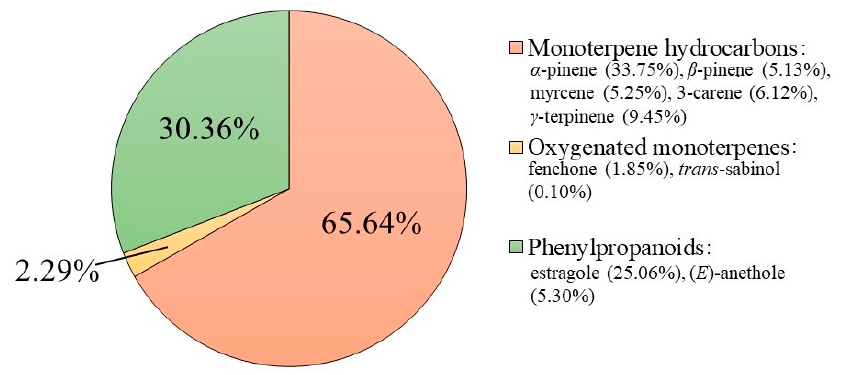
Figure 1. Chemical composition of EO obtained from the leaves of F. vulgare subsp. vulgare var. vulgare . The graph shows the total percentage of the single chemical classes and the majority of compounds identified by GC-MS.